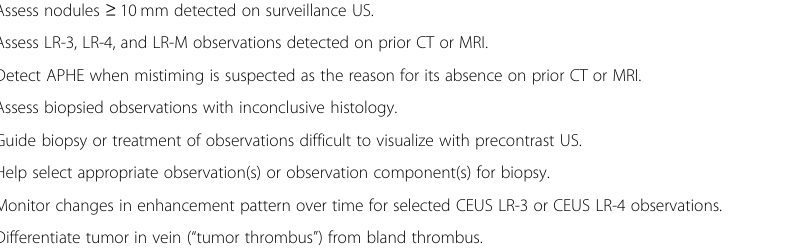
Table 1 Main indications for CEUS LI-RADS in patients at high risk for HCC Assess nodules ≥ 10mm detected on surveillance US.